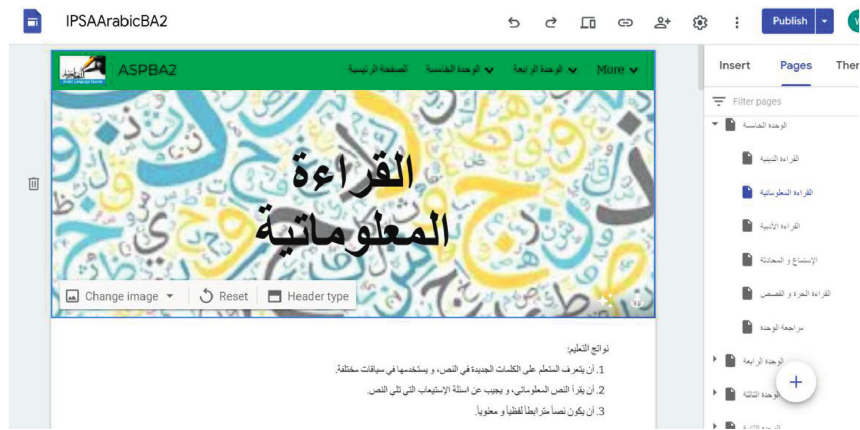
Figure 6: Interface of the blended syllabus [22].